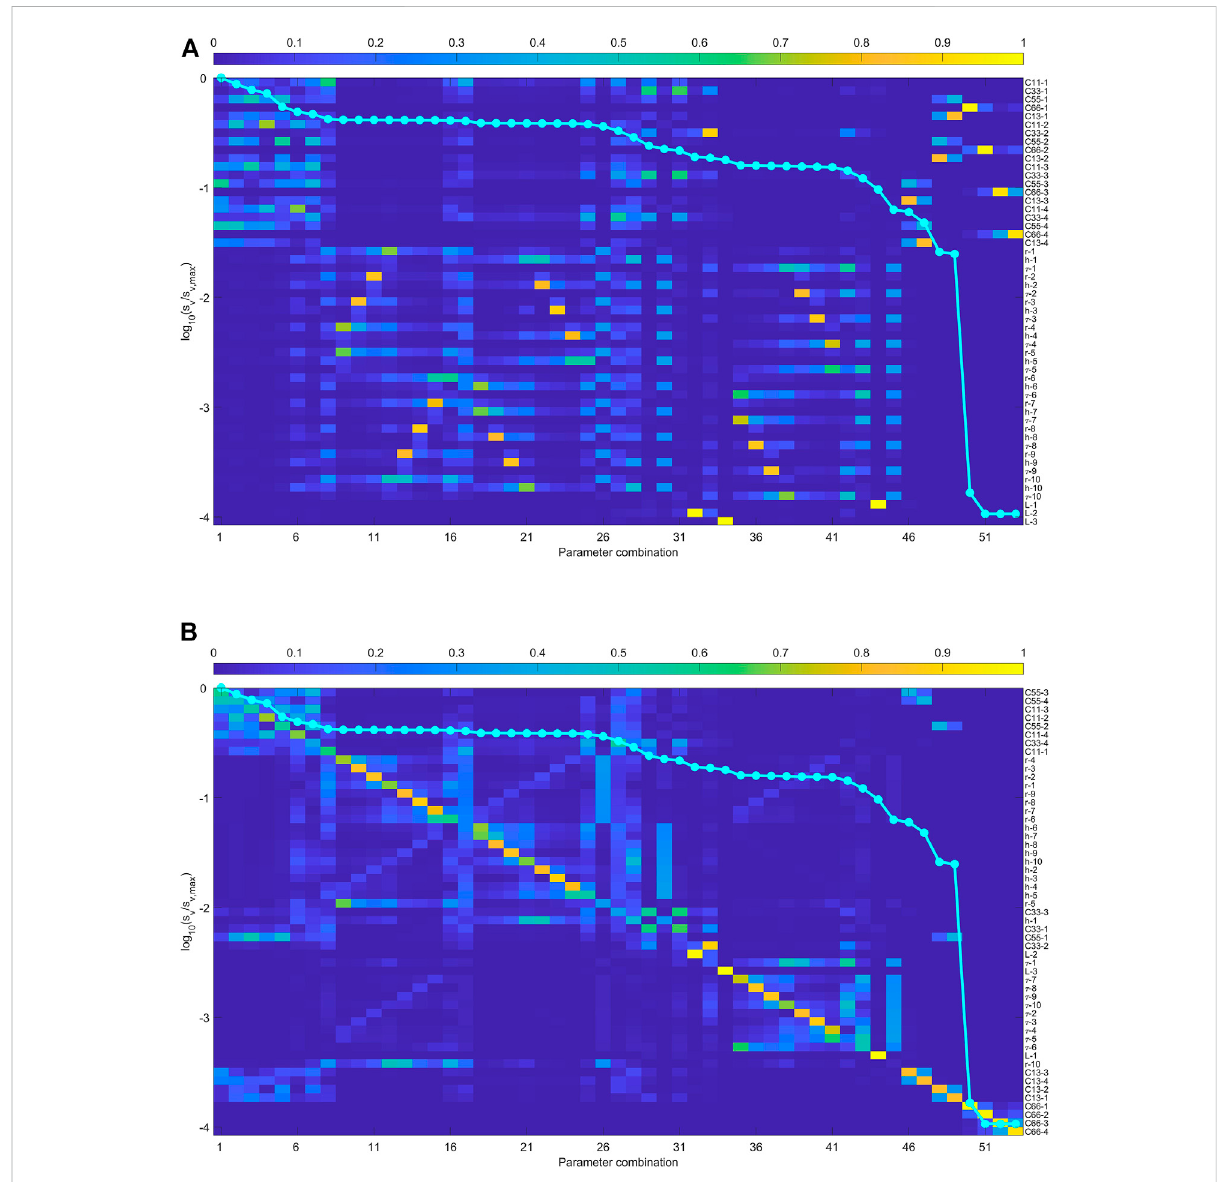
FIGURE 2 (A) The sensitivity analysis of the joint inversion using qP arrival times in the downhole array. The anisotropic is represented by c ij parametrization. (B) the rows of eigenvector matrix are sorted to make it diagonally dominant as possible. The horizontal axis shows the index of eigenvectors, the vertical axis on the left shows the corresponding normalized singular values, and the vertical axis on the right shows the represented parameters. The blue solid dotted line in (B) indicates the suggestion inversion sequence of the unknowns. The singular values close to zero means the parameters on the right do not contribute to the observed